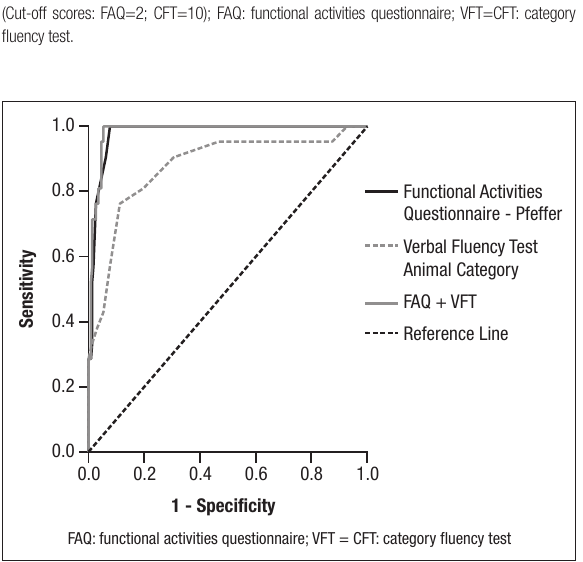
Figure 1. Area under the curve for dementia + CIND × WCI.